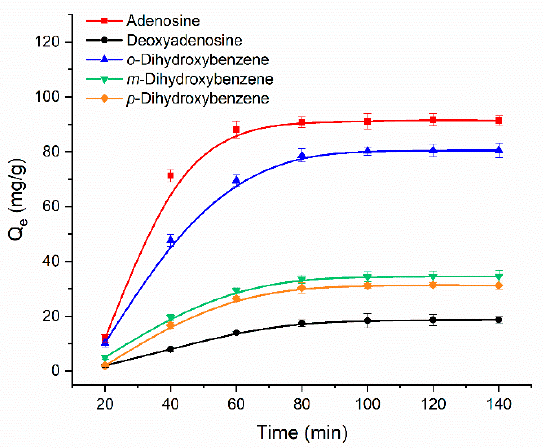
Figure 9. Kinetics of adsorption curves of Fe 3 O 4 @MPTES@VPBA.